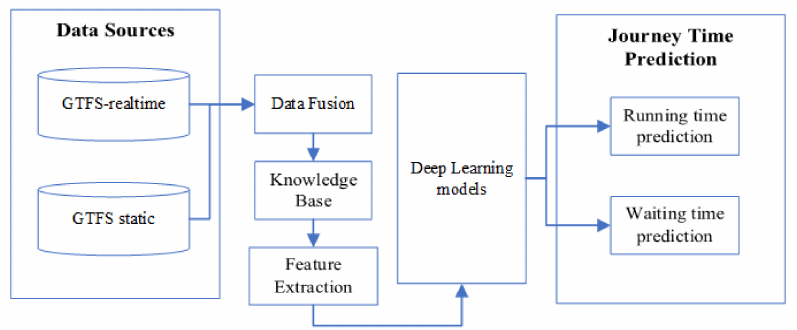
Figure 2. The framework of journey time